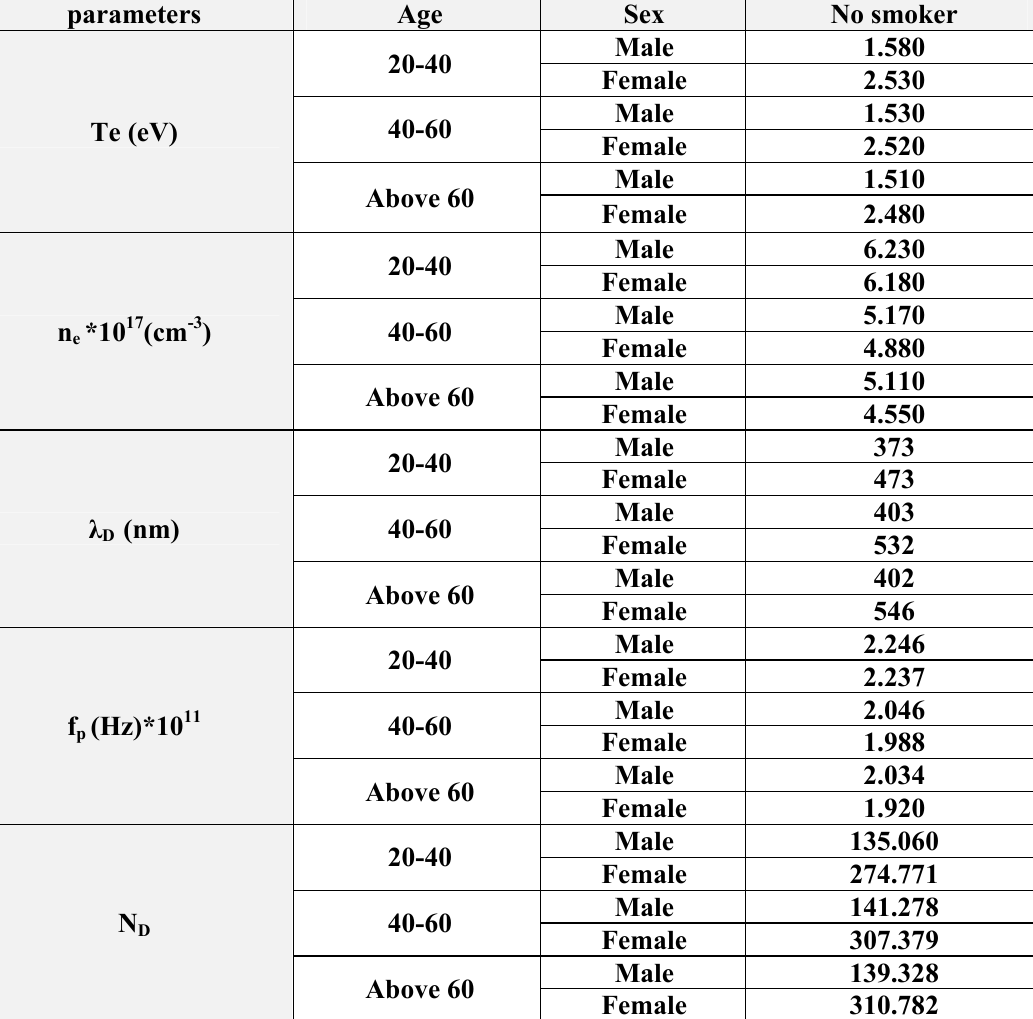
Table 1: Some qualitative analysis of plasma parameters for Ca element.